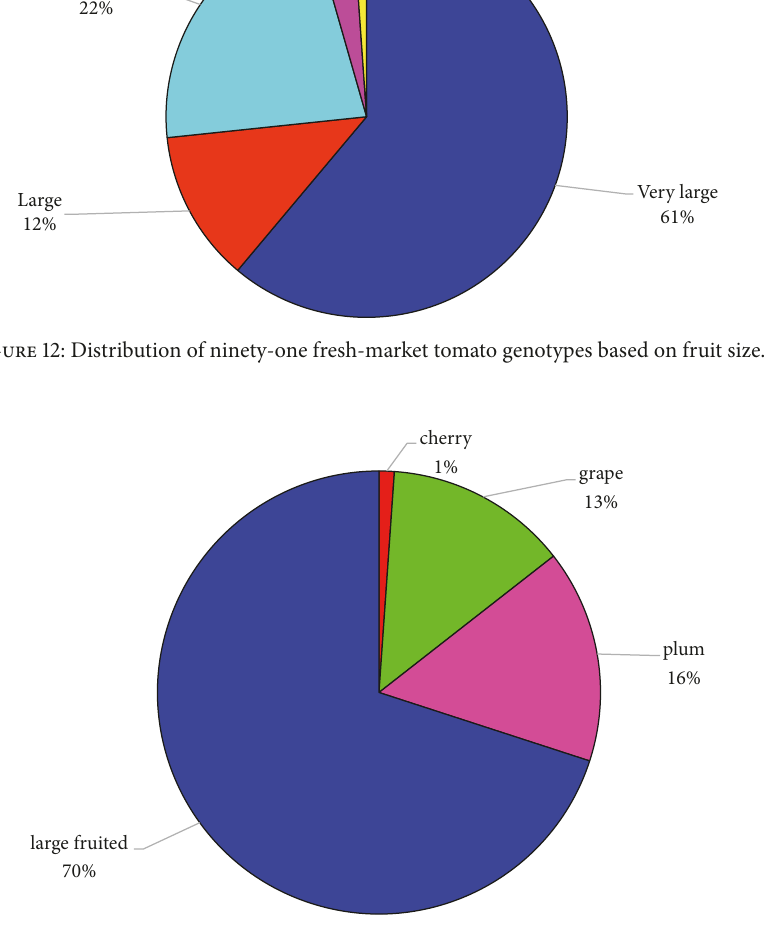
Figure 13: Distribution of ninety-one fresh-market tomato genotypes based on fruit type.